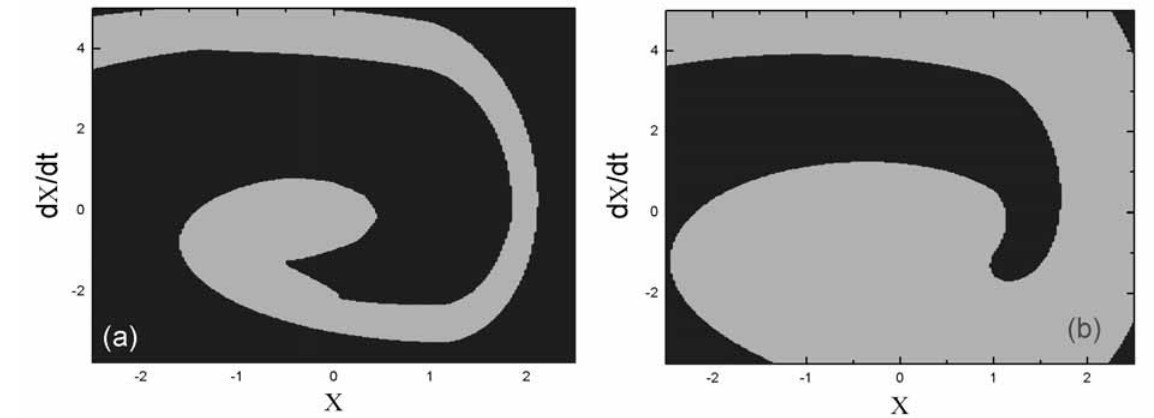
Fig. 7. Basins of attraction for different frequencies. (a) ω = 1.10 rad/s; (b) ω = 1.18